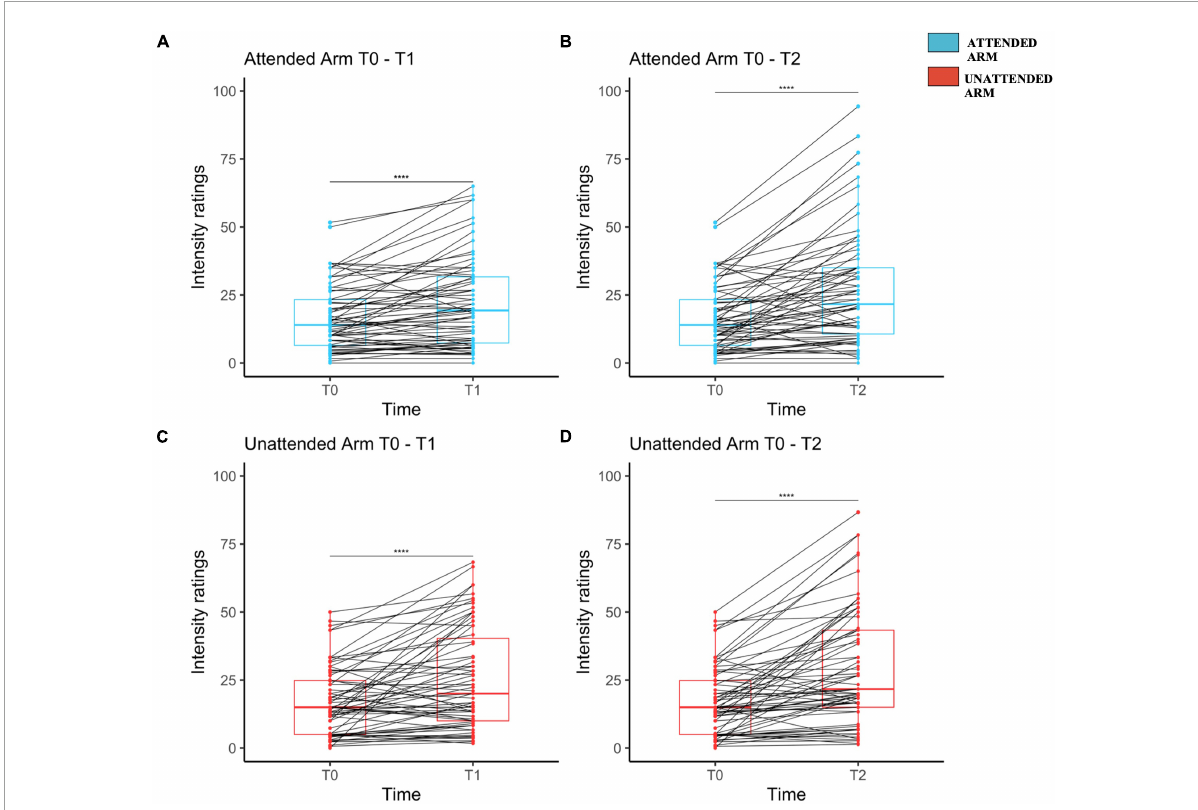
FIGURE2 Mechanical pinprick sensitivity measured separately on each arm and for each time point. Attended arm at T1 (A) and T2 (B) both in comparison to T0. Unattended Arm at T1 (C) and T2 (D) both in comparison to T0. The red (unattended arm) and the blue (attended arm) bold line within each boxplot represents the median of the intensity ratings at each time point. Median intensity of perception ratings measured at T0 were compared to the one at T1 and T2 though a Wilcoxon signed-rank test, separately for each arm. Each dot represents a single participant perceived intensity on the rating scale at the measured time point for Attended Arm from T0 to T1 (A) , and from T0 to T2 (B) , as well as for the Unattended Arm from T0 to T1 (C) and from T0 to T2 (D) . The four stars indicate that there was a significant increase in the perceived